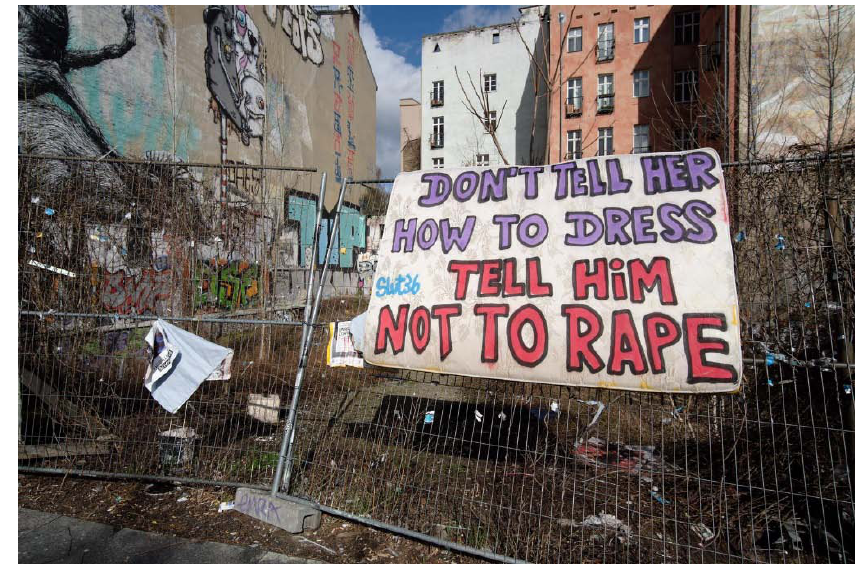
Figure 23. Sozi36, Berlin 2019.